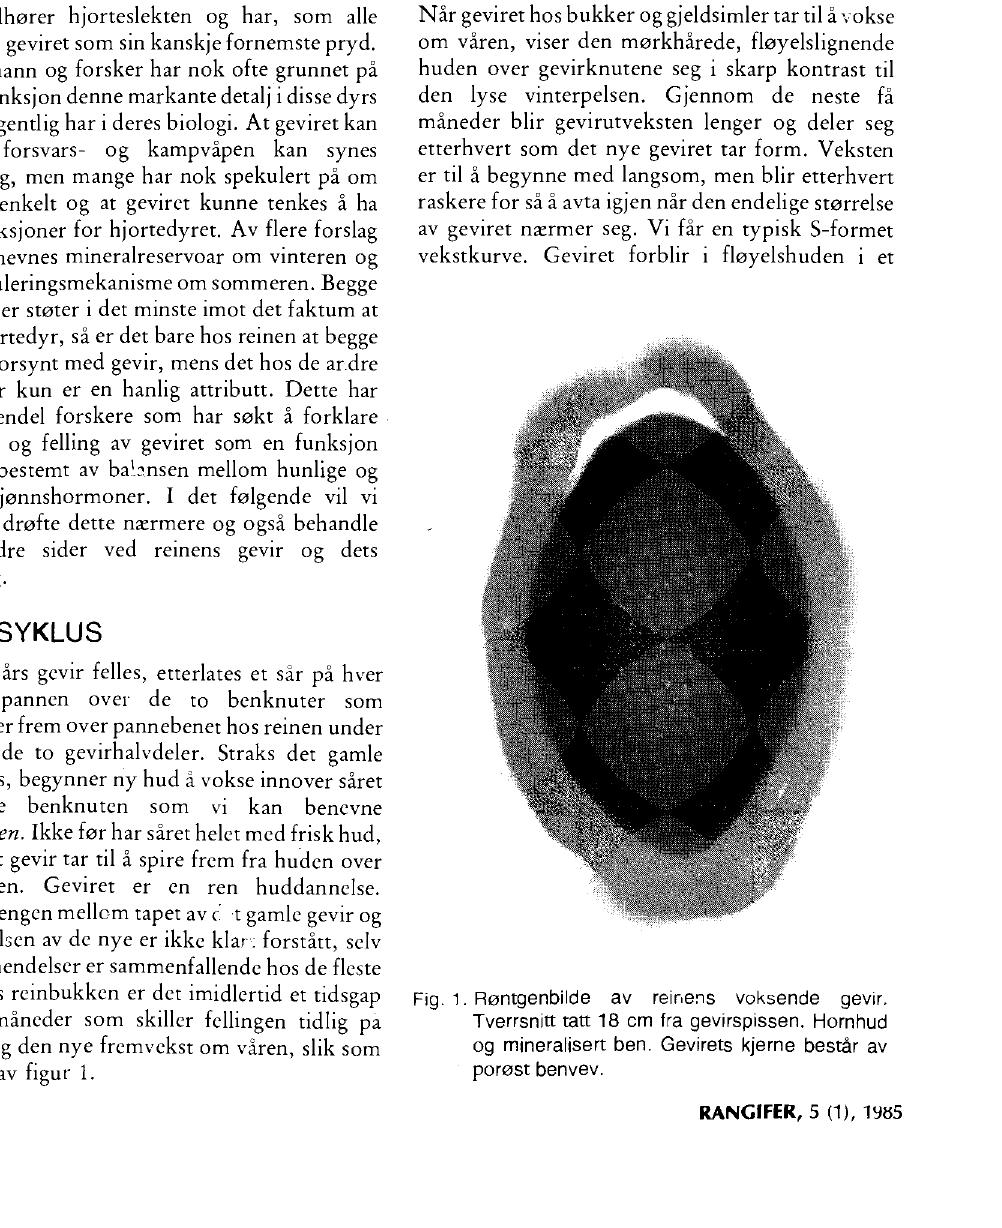
Fig. 1. Røntgenbilde av reinens voksende gevir. Tverrsnitt tatt 18 cm fra gevirspissen. Hornhud og mineralisert ben. Gevirets kjerne består av porøst